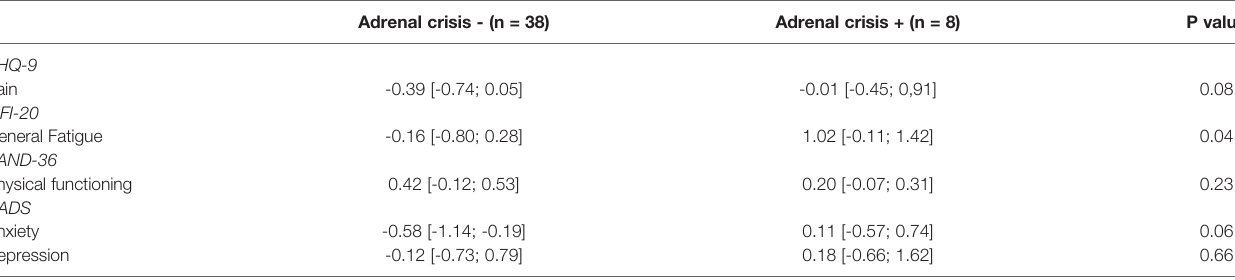
TABLE 6 | Perceived pain, fatigue, physical functioning and mood in patient with and without adrenal crisis on the lower dose hydrocortisone (0.2-0.3 mg/kg/day).